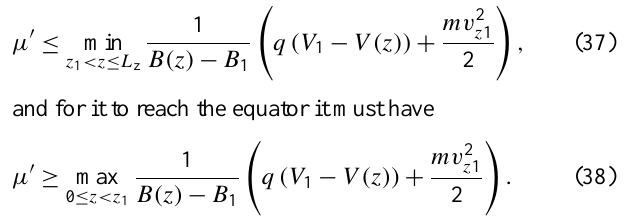
Figure 8 shows the simulated electric field as a function of z for t = 1 s and t = 5 s. In panels (a) and (c) the full z range is shown for these two instants in time. The large neg- ative electric field near z = 5 . 1 × 10 7 m corresponds to the double layer. It looks like a single spike on this scale, but it is resolved in the simulation. The waves on the ion timescale seen in Fig. 4 are seen in Fig. 8c between z = 4 . 5 × 10 7 m and z = 5 × 10 7 m, and they are also visible close to the dou- ble layer in Fig. 8a. In addition to these waves, there are also waves on the electron timescale. These appear near the local plasma frequency, and are seen in Fig. 8 both as wiggles on the electric field curve at high altitude and below the dou- ble layer at much shorter wavelength. Closeups of the low- altitude, high-potential, side of the double layer are seen in Fig. 8b and d for t = 1 s and t = 5 s respectively. We see that these waves are non-uniformly distributed in space, and that at t = 5 s they have been damped away in most of the re- gion. In a small part of the region, near z = 5 . 46 × 10 7 m, they remain with approximately the same amplitude they had at t = 1 s. This can be understood by comparing the dis- tribution functions of the magnetospheric electrons, which are shown in Fig. 9 for z = 5 . 10 × 10 7 m (solid line) and z = 5 . 46 × 10 7 m (dashed line). At z = 5 . 46 × 10 7 m, where the waves remain undiminished, we have a bump on tail dis- tribution, where the bump is formed by the precipitating elec- trons. At z = 5 . 10 × 10 7 m the bump is overshadowed by the trapped electron population. In Fig. 5a it is seen that the trapped distribution gets narrower in velocity as one goes from z = 5 . 10 × 10 7 m – that is to say, near the double layer – toward the